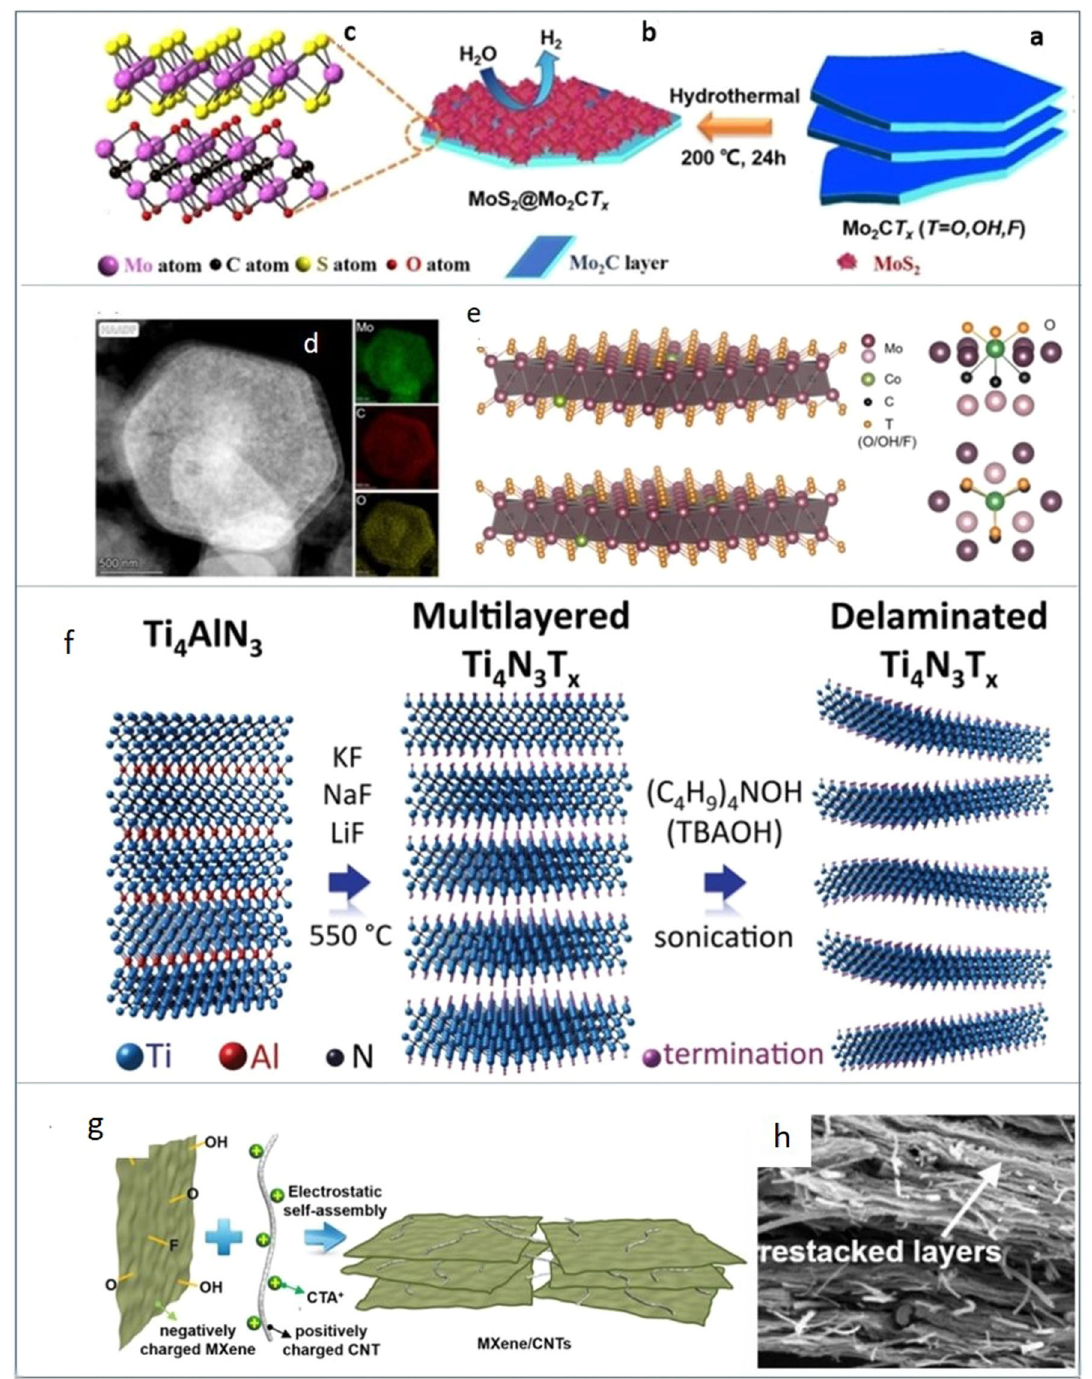
Fig. 5 MXenes as conductive support. a – c The synthesis scheme of MoS 2 @Mo 2 CT x nanohybrids. Reprinted with permission from 71 . d HAADF- STEM micrograph and elemental mapping of delaminated Mo 2 CT x :Co sheets indicating an even distribution of Mo, C, and O atoms within the sheets, e schematic representation of the Mo 2 CT x :Co structure and two projections of the coordination situation of cobalt in Mo 2 CT x :Co. d , e reprinted with permission from 73 Journal of the American Chemical Society 2019, 141, 17809-17816 Publication Date: September 20, (2019) https://doi.org/10.1021/jacs.9b08897 Copyright (2019) American Chemical Society; ( f ) Graphical scheme showing the Ti 4 N 3 T x synthesis from the molten salt treatment of Ti 4 AlN 3 at 550 °C in Ar atmosphere, followed by delamination of the multilayered MXene by TBAOH. Reprinted with permission from 42 . g graphical representation of the porous MXene/CNT electrode by the self-assembly method, h cross-sectional SEM image of restacked Ti 3 C 2 T x /CNT. g , h used with permission from Elsevier B.V./Xie 75